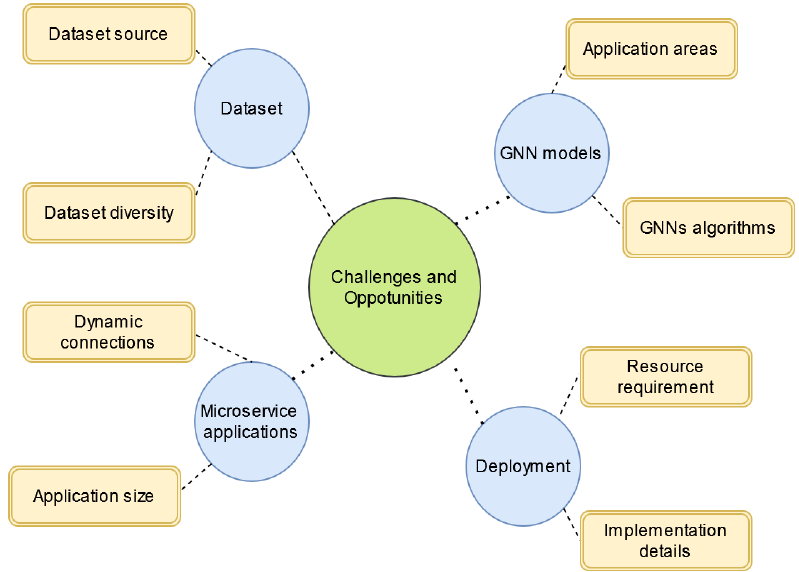
Figure 7. The challenges and opportunities for GNNs for microservice